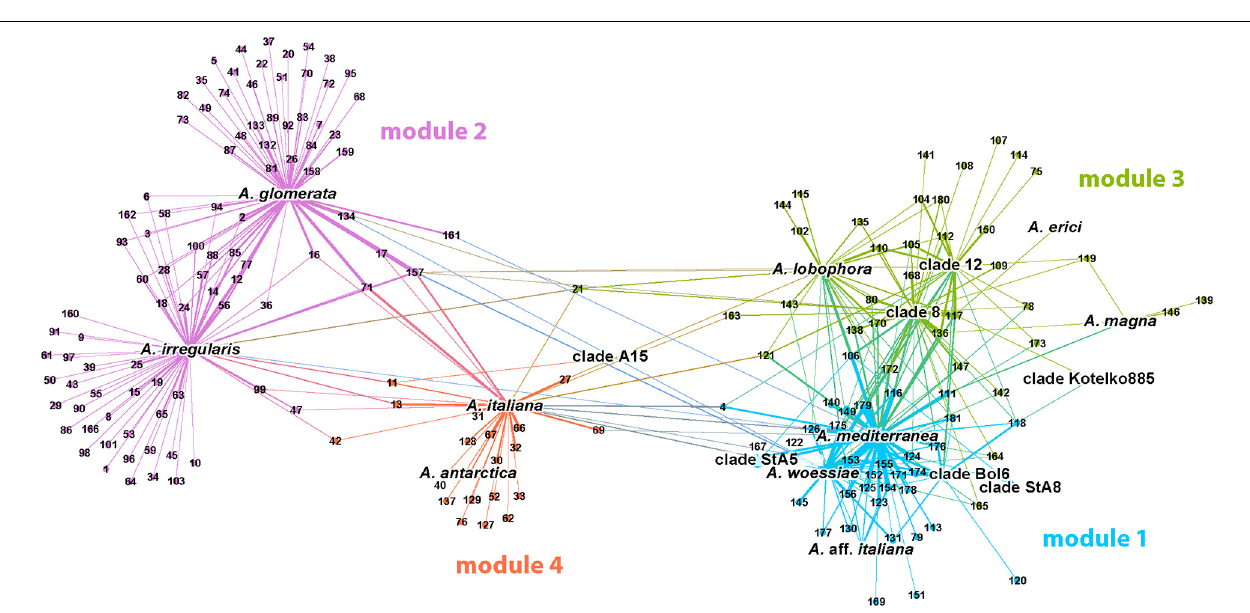
Frontiers in Microbiology |